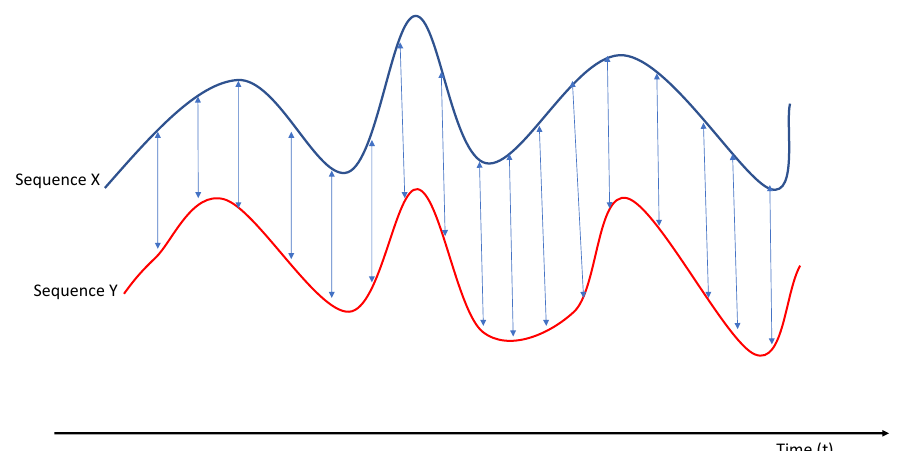
Figure 7. Time alignment of two choreographic sequences. Aligned points are depicted by the